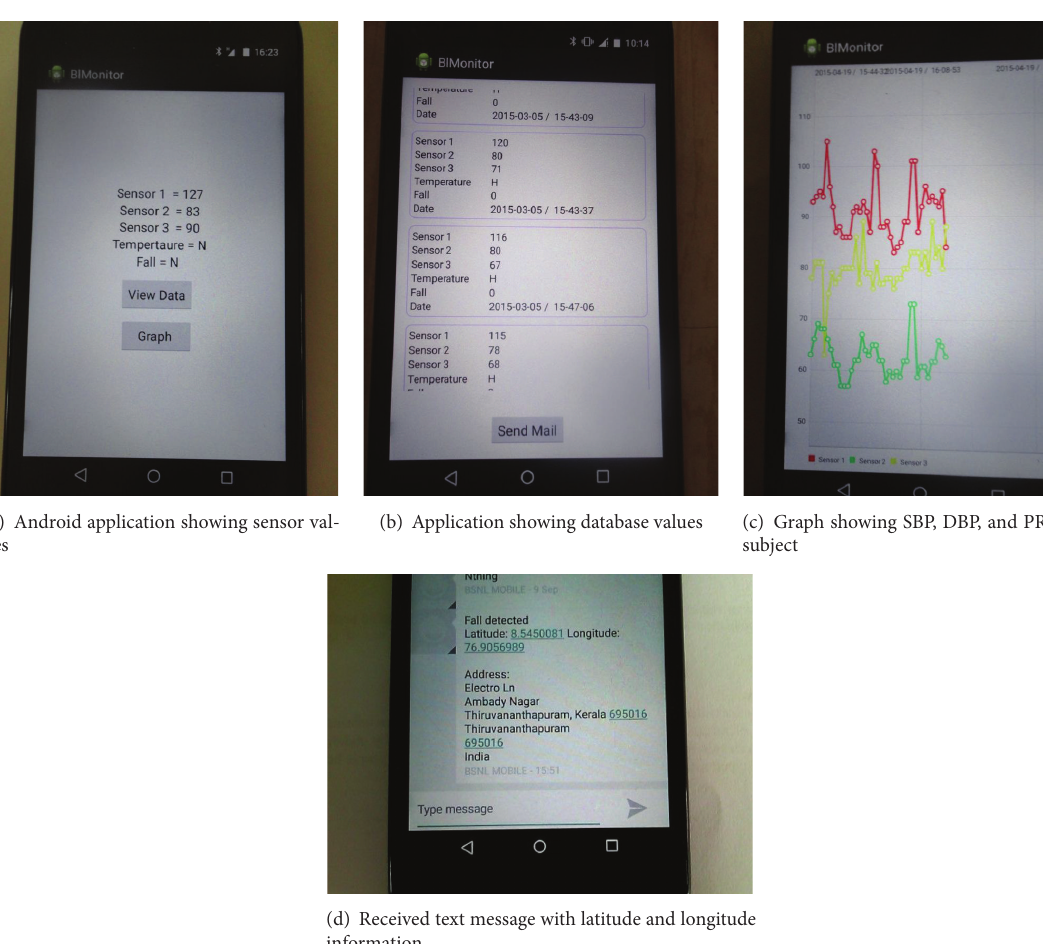
Figure 7: Screen shots of output observed on the tablet PC.